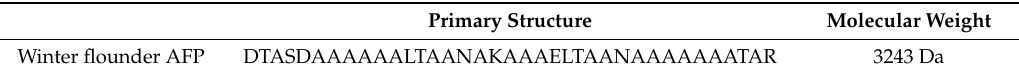
Table 3. Winter flounder antifreeze